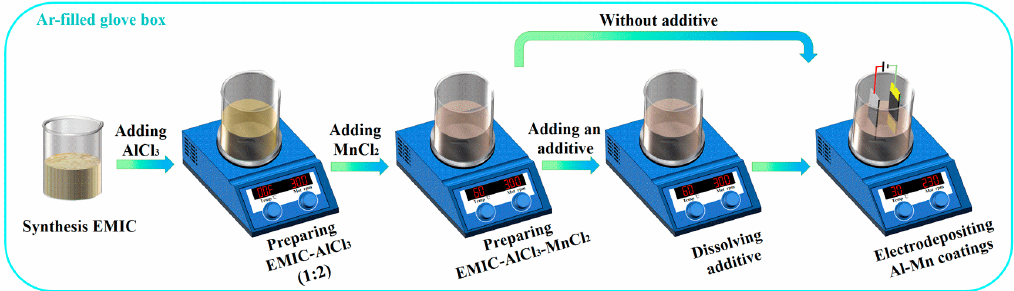
Figure 1. Schematic diagrams about fabrication procedures of the Al-Mn